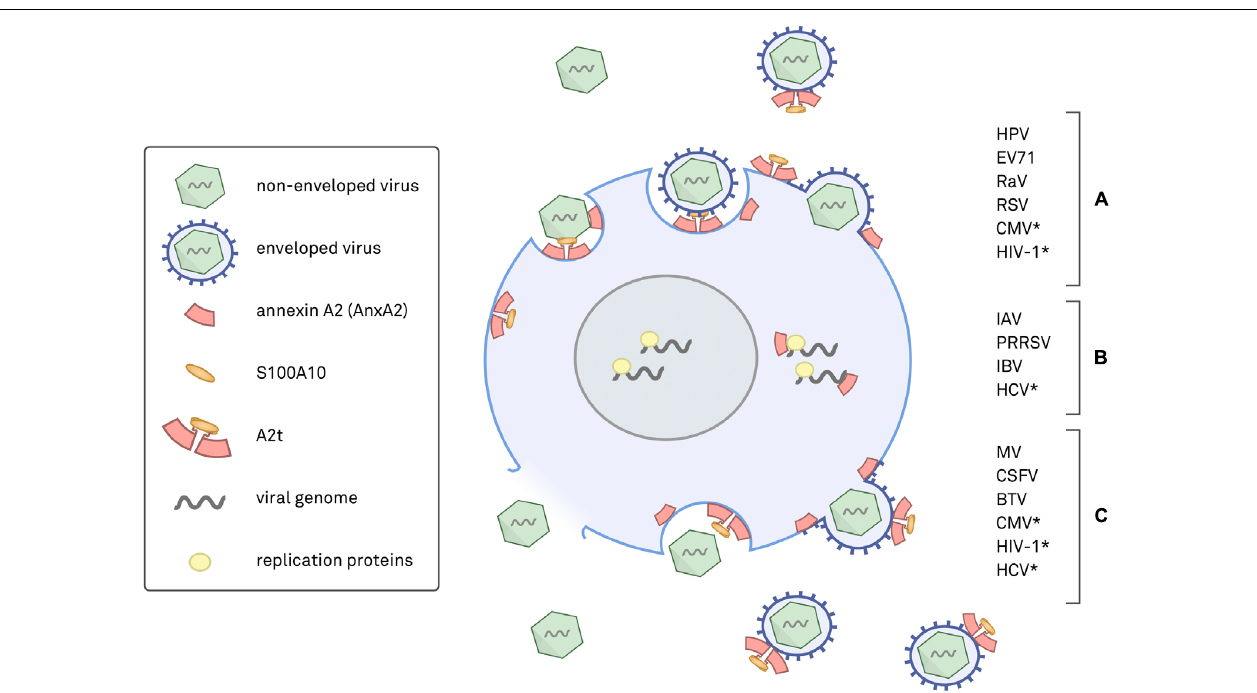
FIGURE 1 | Schematic diagram of annexin A2 (AnxA2) and heterotetrameric AnxA2/S100A10 (A2t) in viral infections. Placements of AnxA2 depict where either AnxA2 or A2t have been implicated in a viral infection. (A) Viruses with evidence for AnxA2 involvement in attachment and entry, which can occur via endocytosis or by fusion of the viral envelope with the plasma membrane. (B) Viruses shown to utilize AnxA2 during genome replication and expression, a process that can occur in the cytoplasm or nucleus. (C) Viruses that have been shown to involve AnxA2 during assembly, maturation, and egress. Assembly can occur in the nucleus or in the cytoplasm, and release is achieved via cell lysis, apoptosis, exocytosis, or direct budding from the plasma membrane. ∗ Evidence for AnxA2 involvement in more than one phase of the viral life